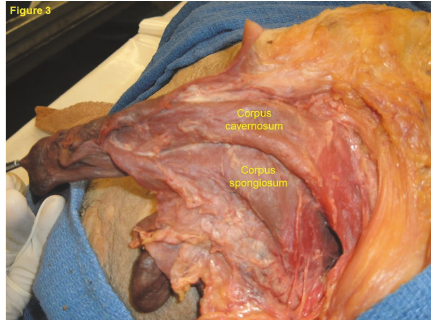
Figure 3: Dissection of the left phallus reveals a corpus cavernosum and corpus